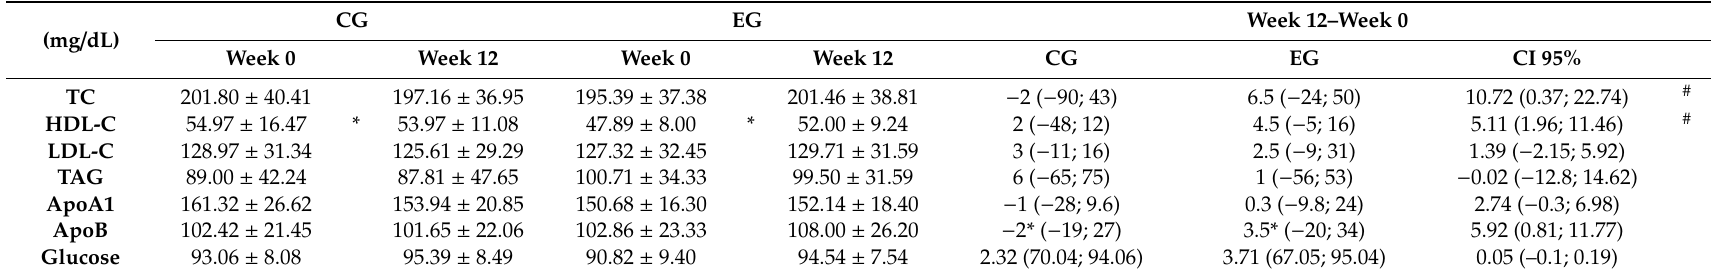
Table 2. Blood lipids and apolipoproteins concentrations before and after